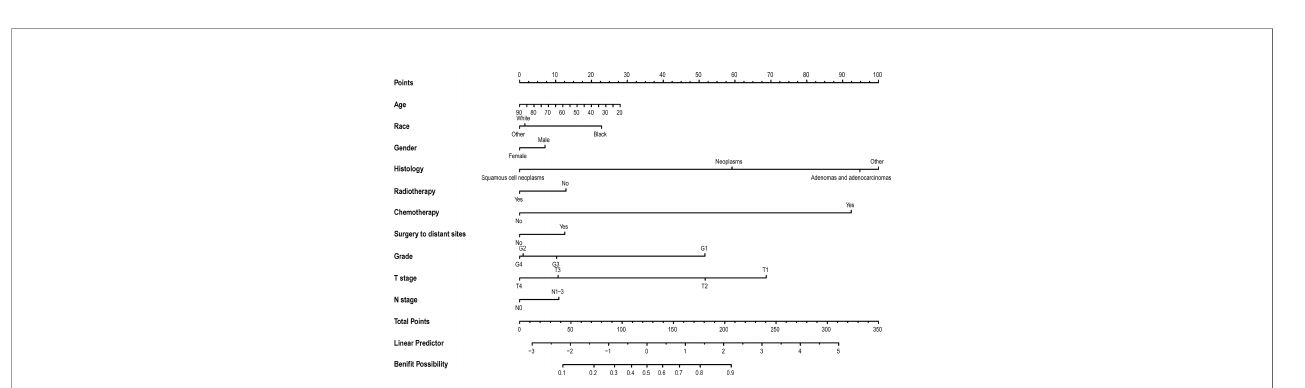
FIGURE 4 | The nomogram to select optimal operable mBC patients who could gain survival bene fi ts from PTR. The calculated score corresponds to a probability. Those whose probability value is greater than 0.5 are optimal operable mBC patients, and vice versa. mBC, metastatic bladder cancer; PTR, primary tumor resection.